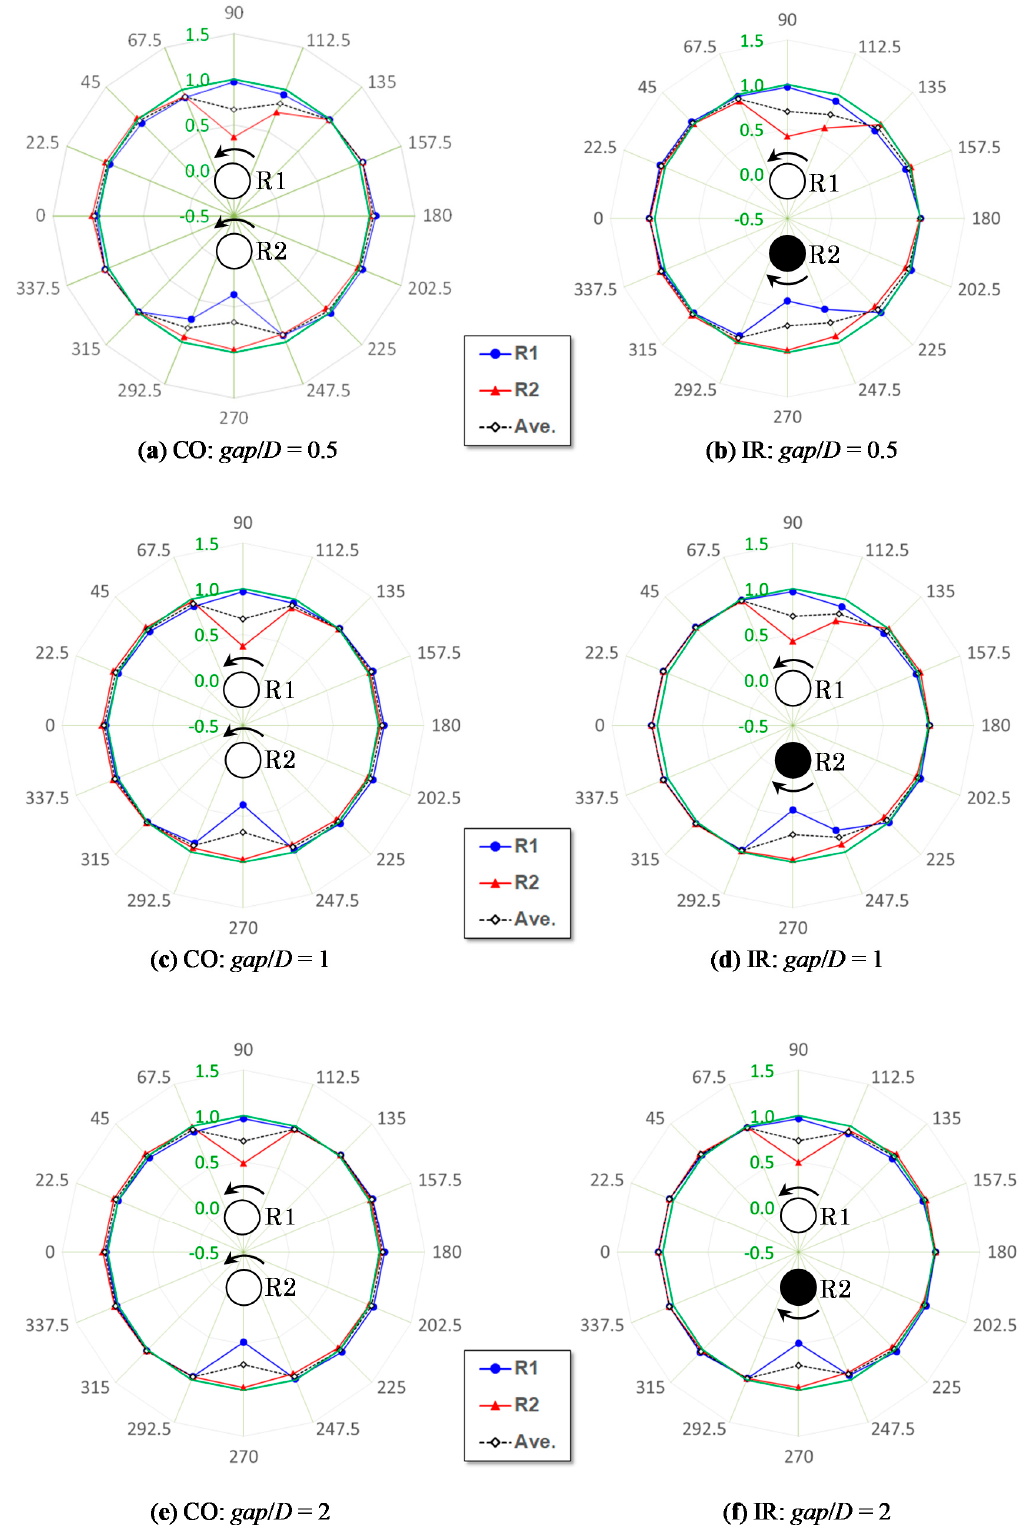
Figure 13. 16-wind-direction dependence of normalized angular velocity: ( a ) CO configuration, gap / D = 0.5; ( b ) IR configuration, gap / D = 0.5; ( c ) CO configuration, gap / D = 1; ( d ) IR configuration, gap / D = 1; ( e ) CO configuration, gap / D = 2; ( f ) IR configuration, gap / D = 2.